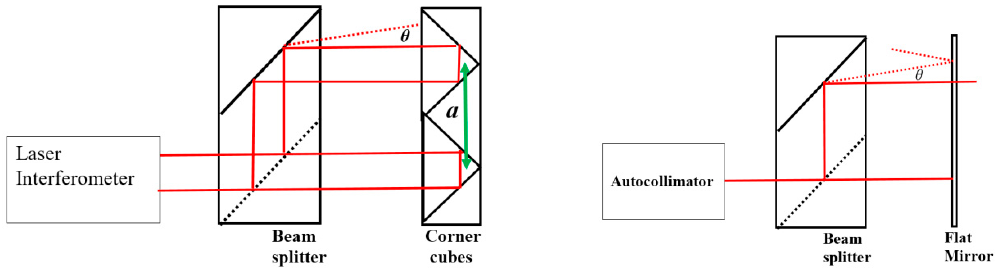
Figure 9. Left: angular optics assembly. a : characteristic distance between central-symmetric points θ : angular deviation of beam splitter assembly. Right: calibration of the angular deviation θ .